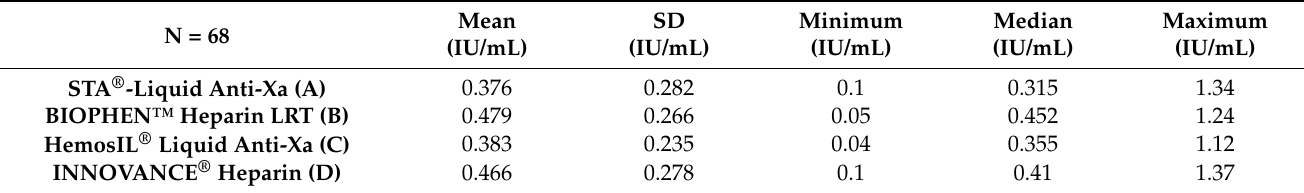
Table 1. Mean heparin concentrations (IU/mL) measured on the 68 plasmas from UFH or LMWH treated patients, using the 4 different anti-FXa kinetic assays (Stago, Werfen-IL, Siemens, and HYPHEN BioMed), blood was collected either on citrate or CTAD anticoagulant, and plasma decanted following centrifugation. Mean SD Minimum Median Maximum N = 68 (IU/mL) (IU/mL) (IU/mL) (IU/mL) STA ® -Liquid Anti-Xa (A) 0.376